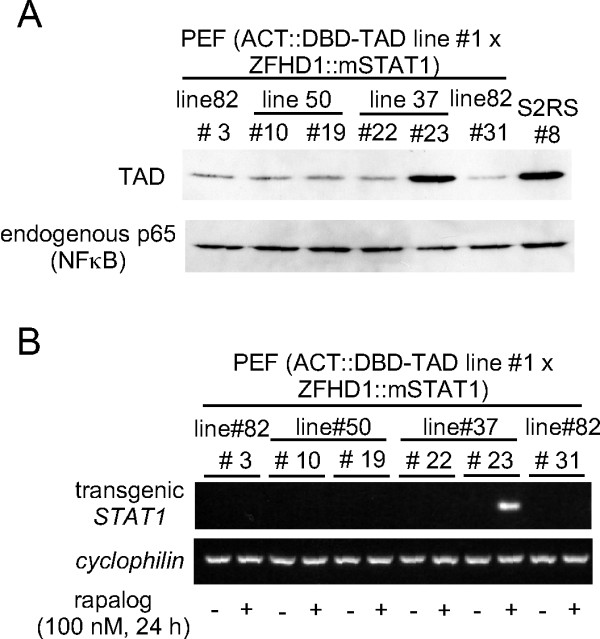
Expression of transcription factor components and transgenic STAT1 in double-transgenic mice. PEF were isolated from double-transgenic mice (ACT::DBD-TAD line #1 × ZFHD1::mSTAT1) and stimulated with rapalog (100 nM) for 24 h or left untreated (A, B). Cells were lysed, and WB was performed to detect TAD. p65/NFκB was used as endogenous control (A). RNA was isolated and RT-PCR performed to detect transgenic STAT1 mRNA; cyclophilin was used as endogenous control (B).